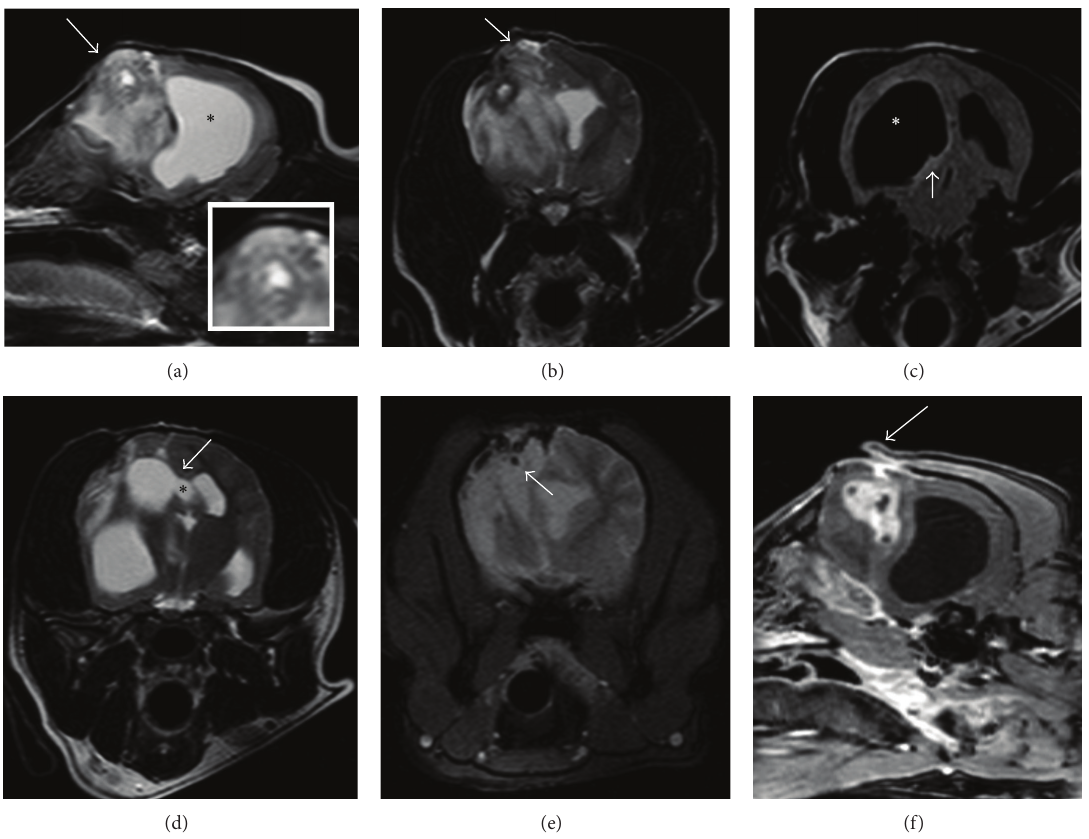
Figure 1: Preoperative magnetic resonance (MR) images of the head. (a) T2-weighted right parasagittal image. There is a predominantly T2-hyperintense mass in the right cerebrum underlying a calvarial defect (arrow) and significant dilation of the right lateral ventricle (asterisk). Inset: note the multiple rims of alternating intensity surrounding the T2-hyperintense center, not suppressed on a T2-weighted FLAIR sequence. (b) T2-weighted transverse image at the level of the optic chiasm. The mass is causing midline shift toward the left and brain herniation through the calvarial defect (arrow). (c) T2-weighted FLAIR transverse image at the level of the midbrain. There is hyperintensity immediately surrounding the markedly dilated right lateral ventricle (asterisk) and descending transtentorial herniation of the right parahippocampal gyrus (arrow). (d) T2-weighted transverse image at the level of the caudal thalamus. There is subfalcine herniation of the right cingulate gyrus (arrow) and part of the right lateral ventricle (asterisk). (e) T2 ∗ -weighted transverse image at the level of the optic chiasm. There are several irregular areas of signal void, one (arrow) that corresponds with the bone fragment seen on CT imaging. (f) Postcontrast T1-weighted gradient-recalled echo right parasagittal image. There are three pockets of T1-hypointense material surrounded by a strongly contrast-enhancing rim. Note the elevated bone flap that incompletely spans the calvarial defect